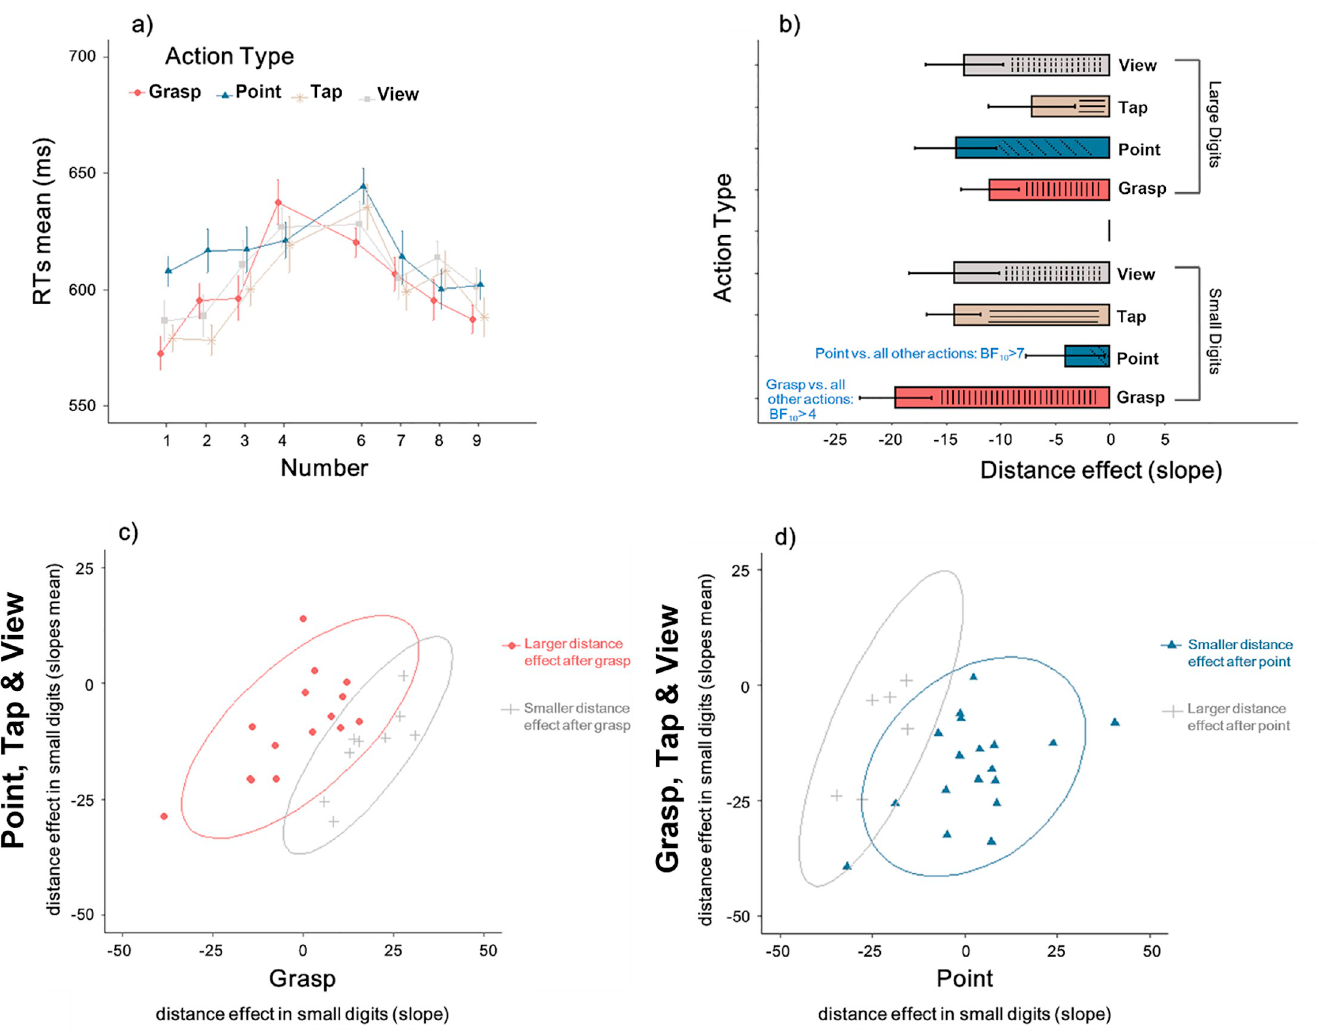
Fig 3. Panel a . RTs as a function of number target and action type . Error bars represent within-subjects SEM, computed only for illustration purposes [74]. Panel b . Regression slopes representing the size of the distance effect for small or large digits in each action type condition . Error bars represent SEM. Results from exploratory analyses are written in blue. Panel c . Individual regression slopes as a function of numerical distance in the grasp–small number condition . Negative slopes indicate performance in the direction of the classical distance effect (i.e., faster responses for digits far from the reference as compared to closer ones). Red circles indicate more negative slopes for small numbers after grasping as compared to the other conditions. Grey crosses indicate more negative slopes for small numbers after tapping, pointing, and viewing as compared to the grasping condition. Panel d. Individual regression slopes as a function of numerical distance in the point–small number condition . Negative slopes indicate performance in the direction of the classical distance effect (i.e., faster responses for digits far from the reference as compared to closer ones). Blue triangles indicate less negative slopes for small numbers after pointing as compared to the other conditions. Grey crosses indicate less negative slopes for small numbers after tapping, grasping, and viewing as compared to the pointing